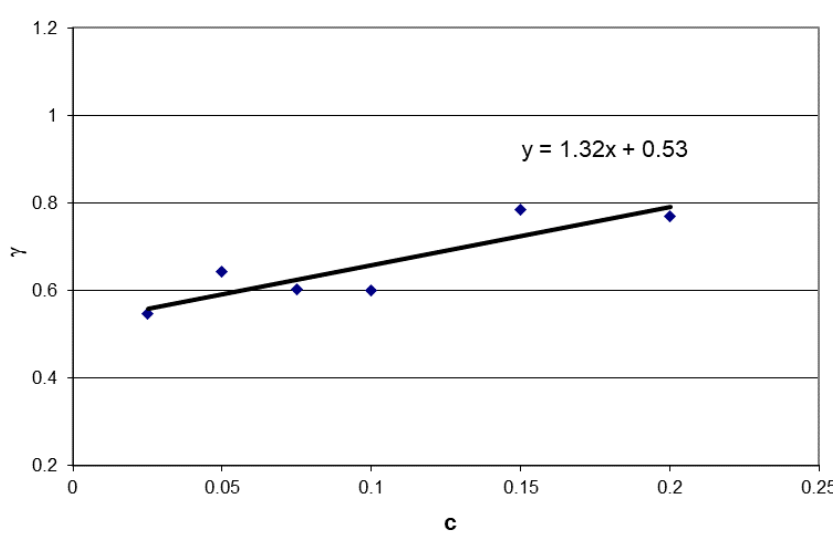
Figure 11. Plot of exponent γ on c for folded, four-blade turbine.